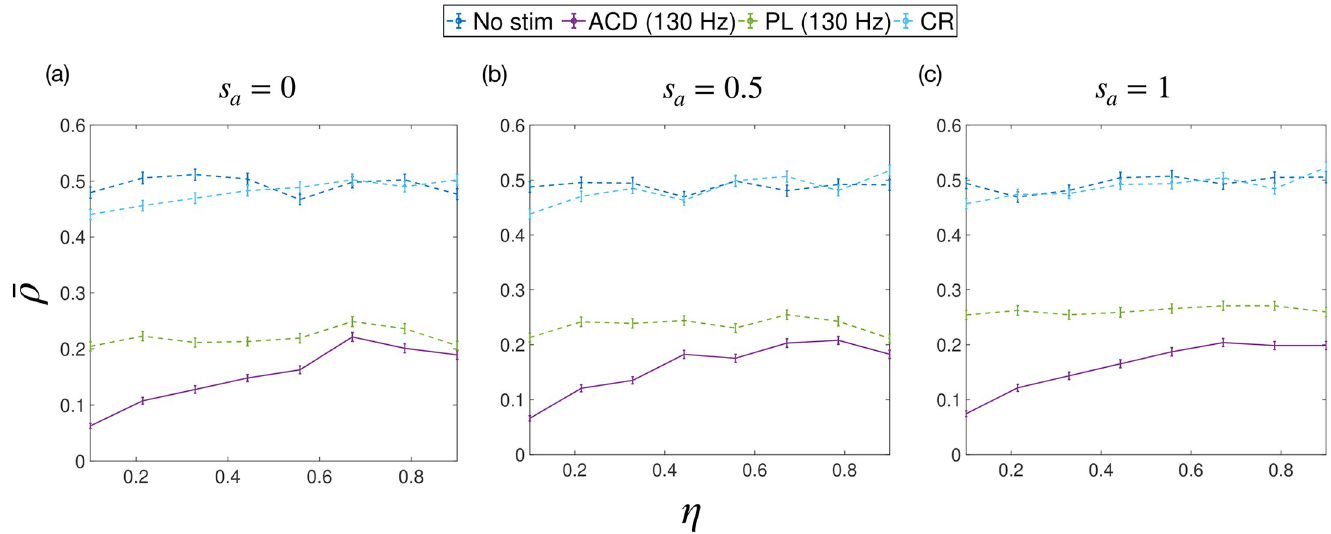
Fig 10. The average amplitude of simulated data � r as a function of the configuration parameter η . The strategies tested were: no stimulation (no stim), adaptive coordinated desynchronisation (ACD), phase-locked (PL) and coordinated reset (CR). The average amplitude is a measurement of efficacy, where lower amplitudes indicate higher efficacy. The maximum stimulation frequencies used for ACD and PL are also given in the legend. Each sub plot shows a set of simulations performed with a particular value for the standard deviation of the zeroth harmonic of the uPRC s . a